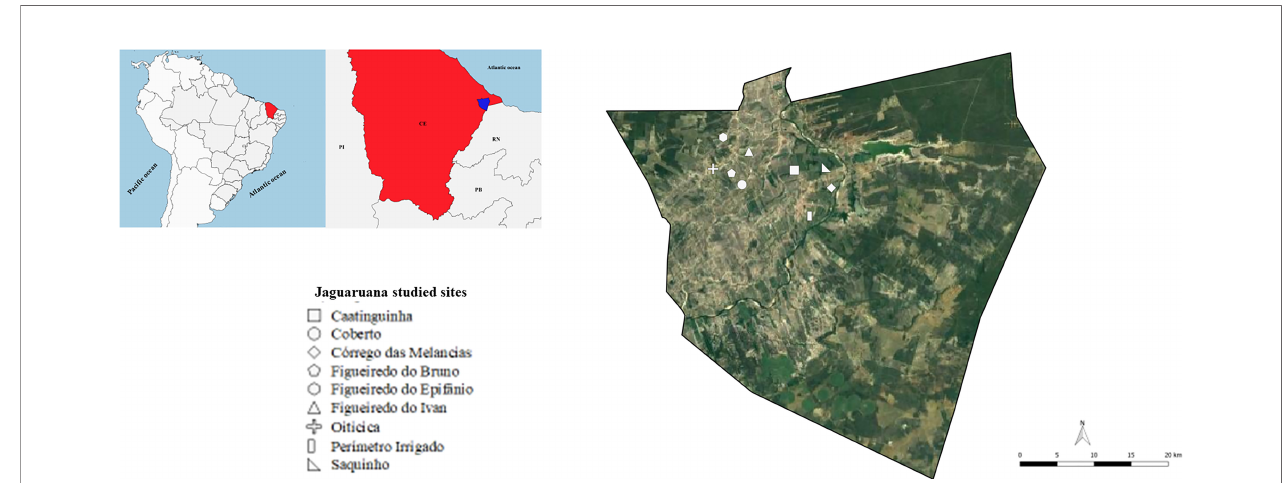
FIGURE 1 | Jaguaruana municipality map, Ceara ́ state, northeast Brazil. The red area represents Ceara ́ state, and the blue area represents Jaguaruana municipality. Each dot represents locations where DNA samples were obtained. CE, Ceara ́ state; PI, Piau ı ́ state; RN, Rio Grande do Norte state; PB, Para ı ́ ba state. Data sources: Instituto Brasileiro de Geogra fi a e Estat ı ́ stica – IBGE (www.ibge.gov.br); Google Earth (https://www.google.com.br/intl/pt-BR/earth/). The map was constructed using QGIS software v.2.18.15. Unfortunately, the location of the two rats included in this study could not be identi fi